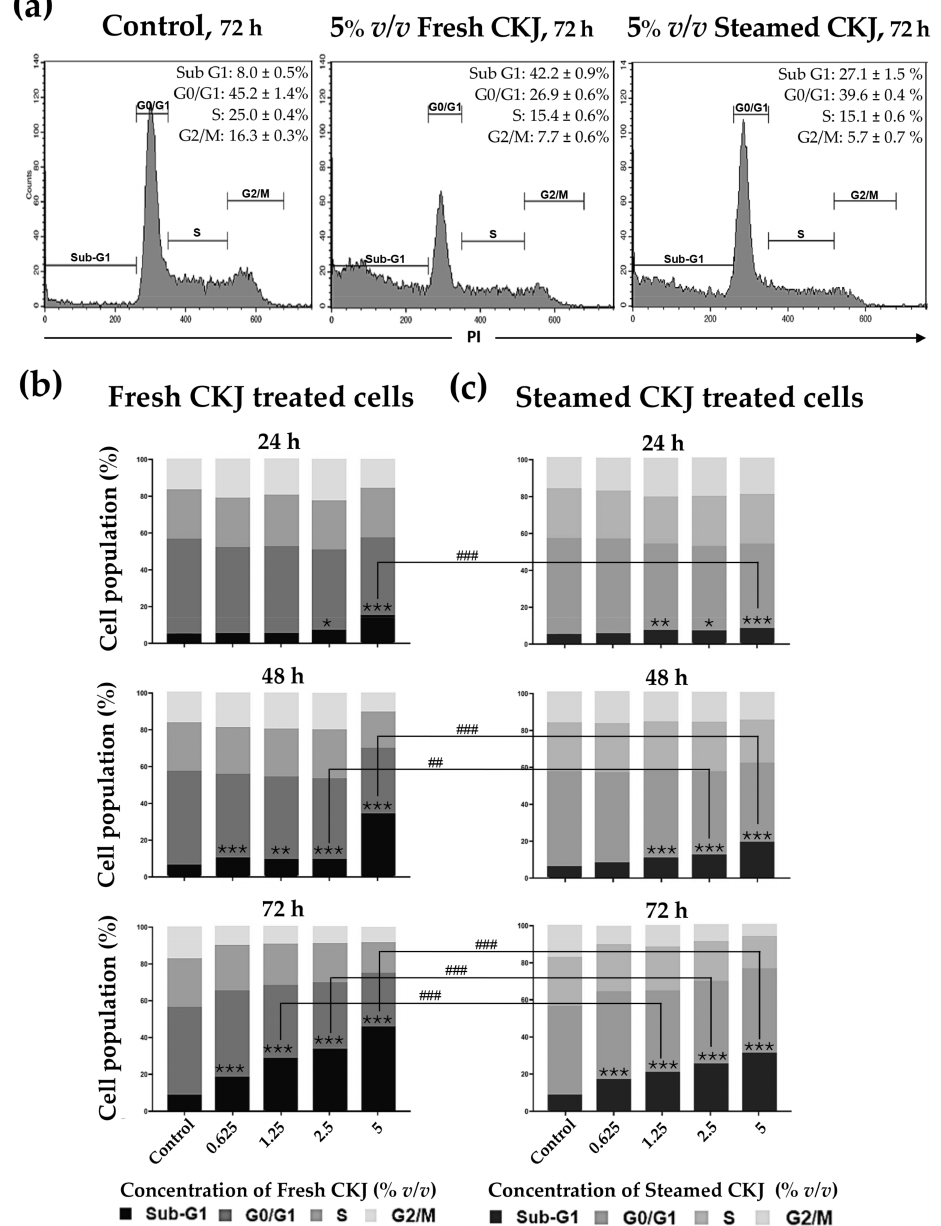
Figure 2. The distribution of U937 cells by cell cycle phase after treatment with fresh or steamed CKJ for 72 h. The flow cytometry profiles are shown in histograms ( a ) and the percentage of cells that were treated with various concentrations of fresh CKJ ( b ) and steamed CKJ ( c ) in the Sub G1, G0/G1, S, and G2/M phases are presented. The significance level of the tested sets was compared with a control (normal saline) set (* p = 0.05, ** p = 0.01, and *** p < 0.001) and fresh CKJ-treated cells were compared with steamed CKJ-treated cells (## p = 0.01 and ### p < 0.001). Data are representative of at least three independent